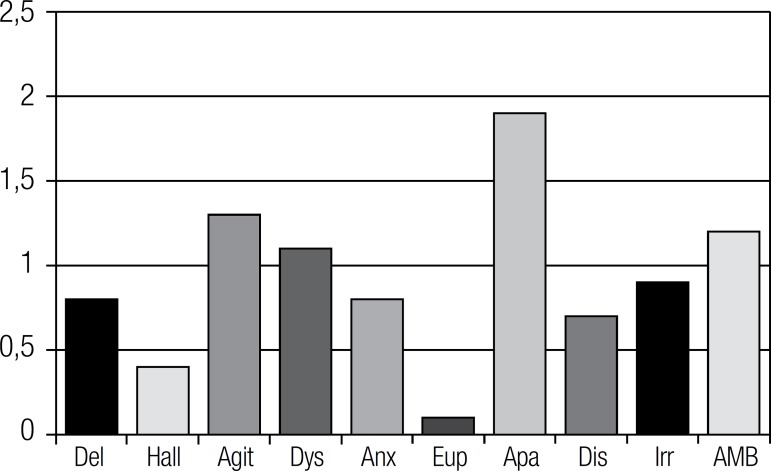
Caregiver distress according to individual NPS (mean) (N=159).